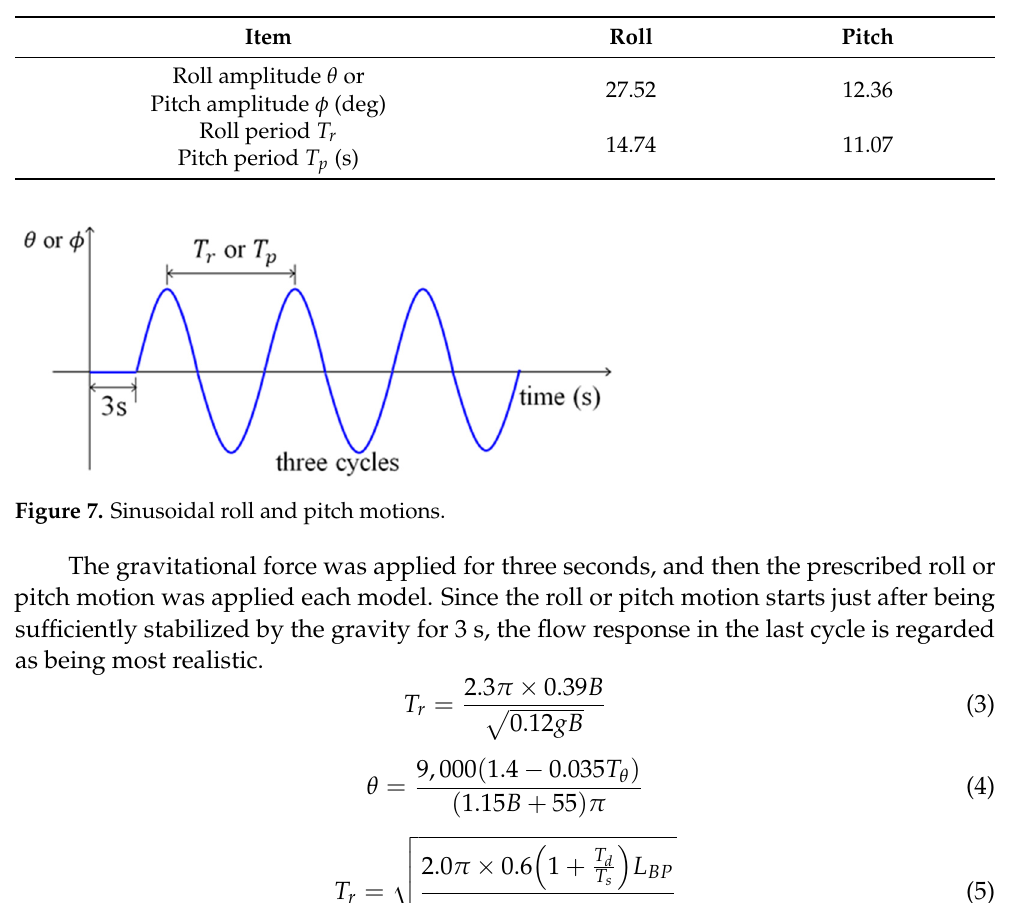
Table 2. The determined roll and pitch angles and periods.